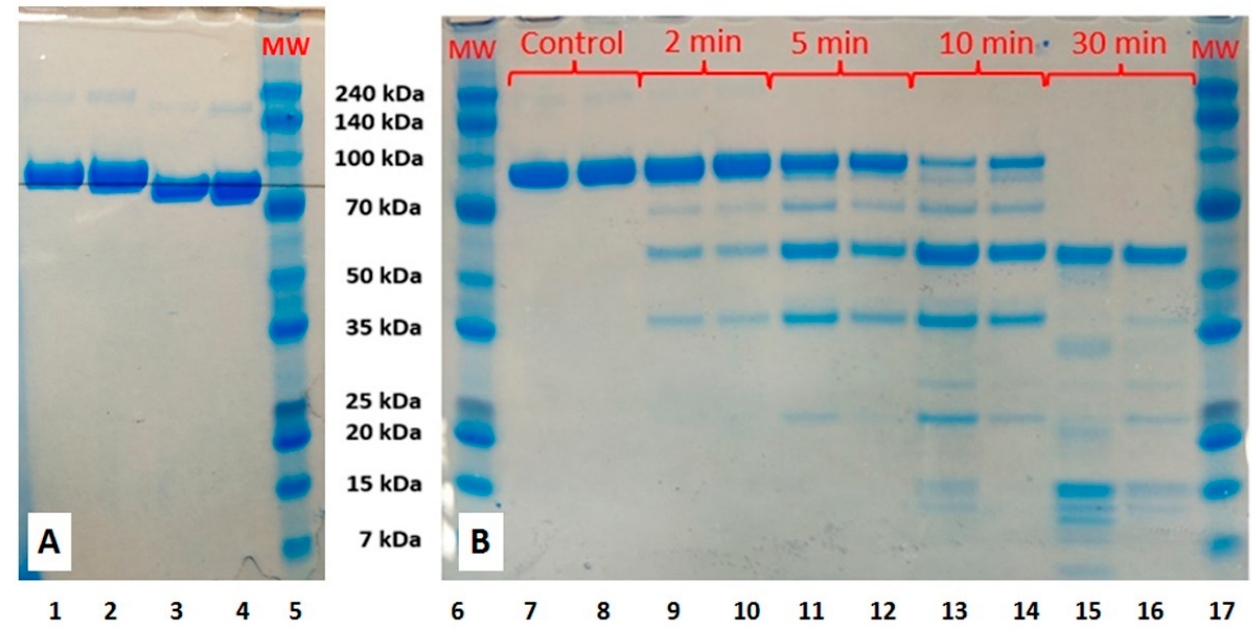
Figure 8. SDS-PAGE of ( A ) bLTF and AgbLTF1200 in reduced (1,2) and nonreduced mode (3,4), and ( B ) the peptic digestion kinetics, where bLTF is presented on 1,3,7,9,11,13,15, AgLTF1200 complex on 1,3,8,10,12,14,16, and markers on 5, 6, 17.